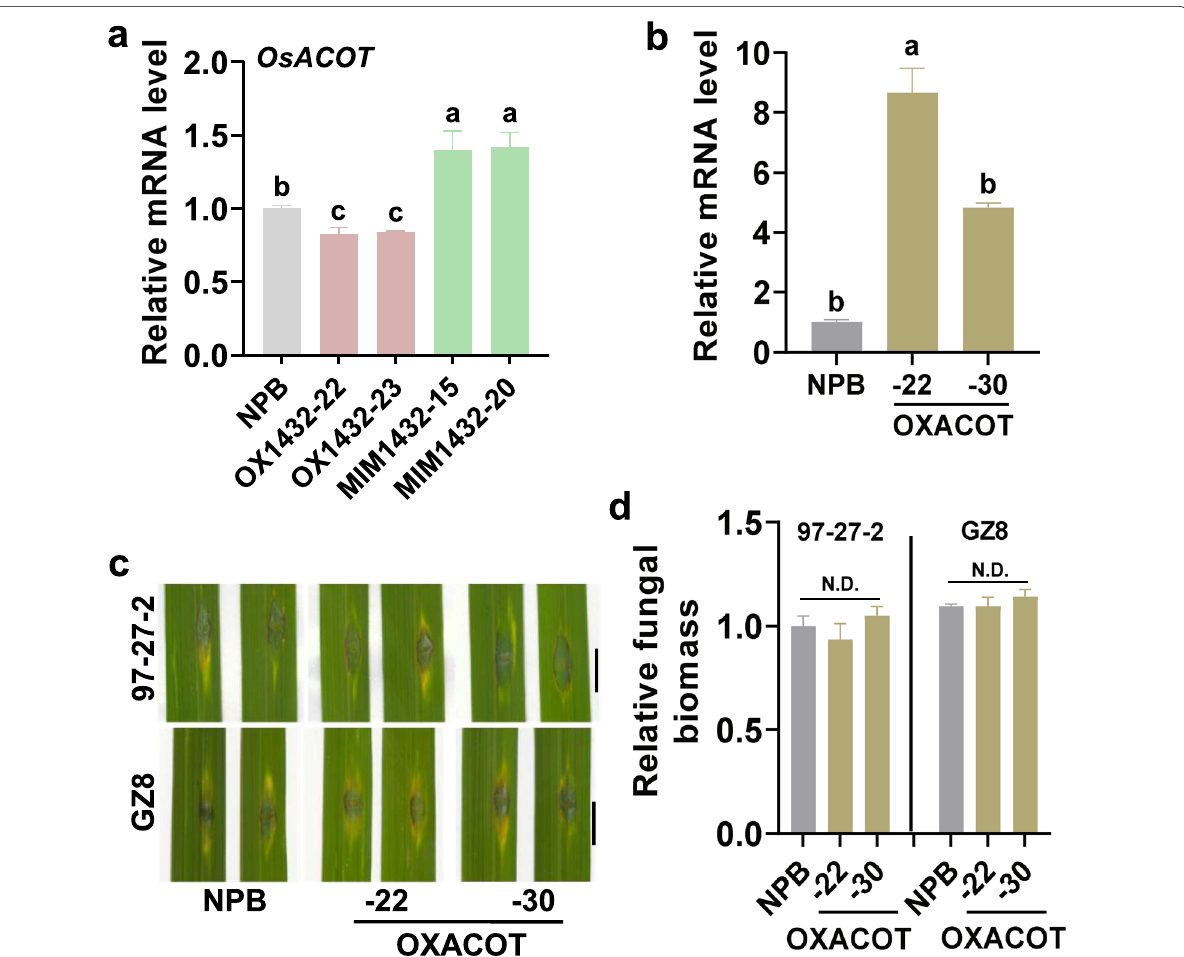
Fig. 6 OsACOT is not involved in the regulation of rice blast resistance. a The relative mRNA levels of OsACOT in OX1432, MIM1432, and the Nipponbare control (NPB). b The relative mRNA levels of OsACOT in the transgenic lines overexpressing OsACOT (OXACOT) and the Nipponbare control. For a and b, total RNA was extracted from three to five‑leaf stage seedlings for reverse transcription‑quantitative polymerase chain reaction (RT‑qPCR) analysis. c Blast disease phenotypes of OXACOT and the Nipponbare control at 5 days post‑inoculation (dpi) of indicated M. oryzae strains. Bar 5 mm. d Quantification analysis of the relative fungal biomass in c. The relative fungal biomass was measured by using the ratio of DNA = level of M. oryzae MoPot2 genes against that of rice ubiquitin. For a, b, and d, error bars indicate SD (n difference as determined by a one‑way ANOVA analysis. All the experiments were repeated two times with similar results